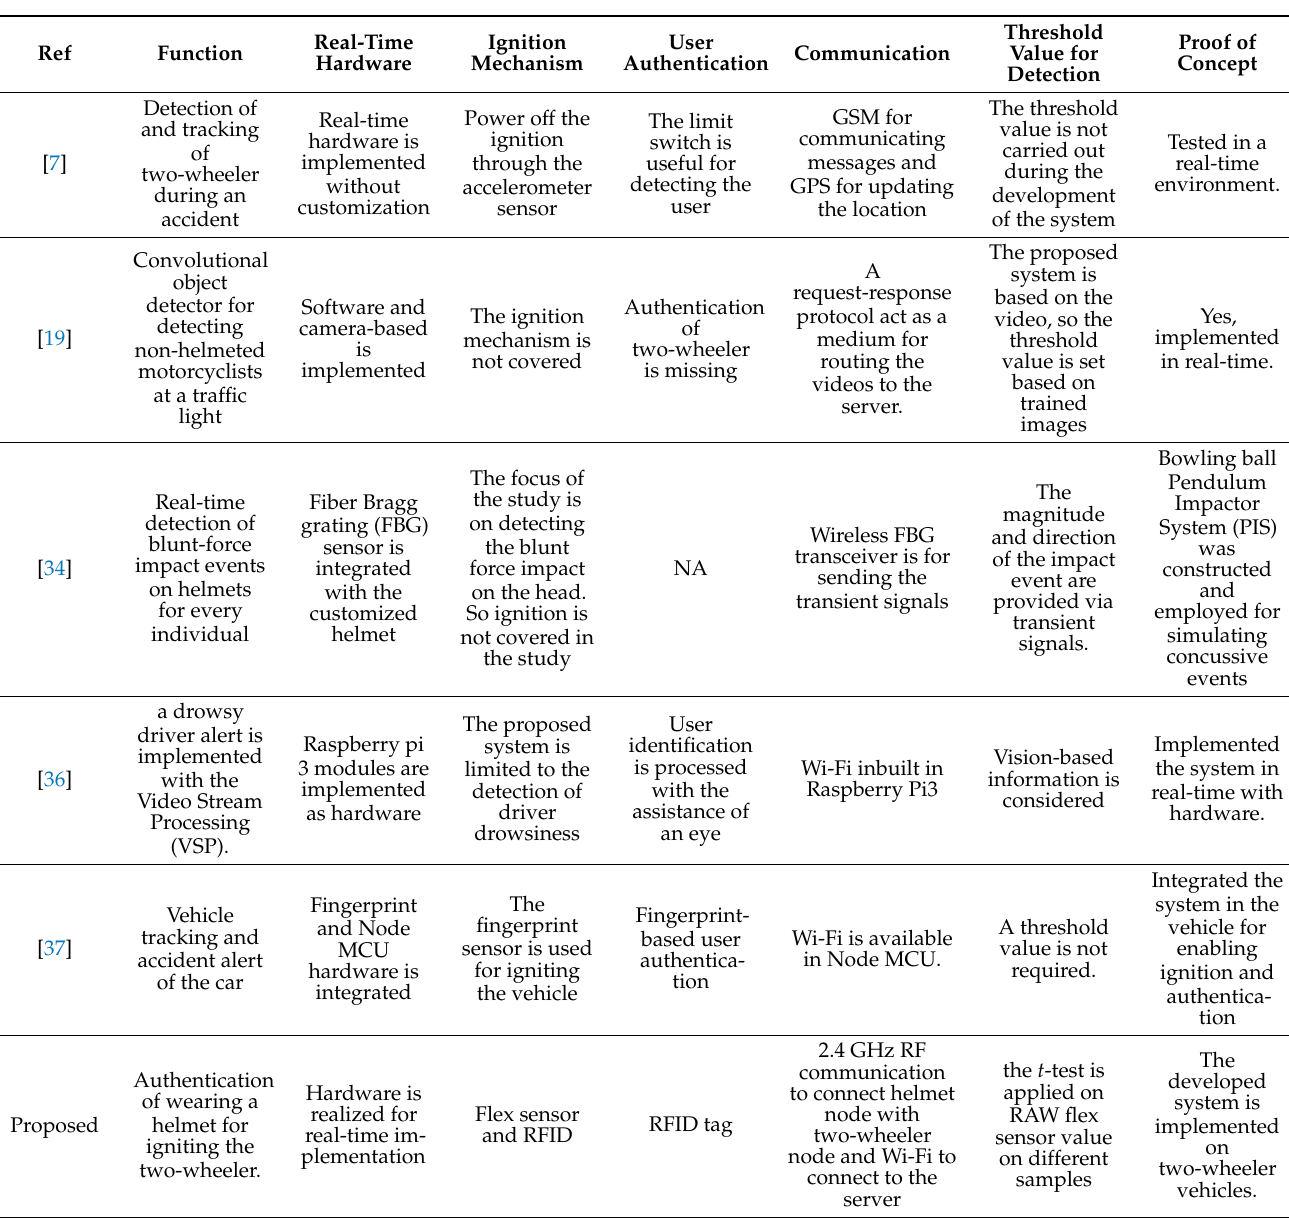
Table 1. Comparison of proposed study with existing